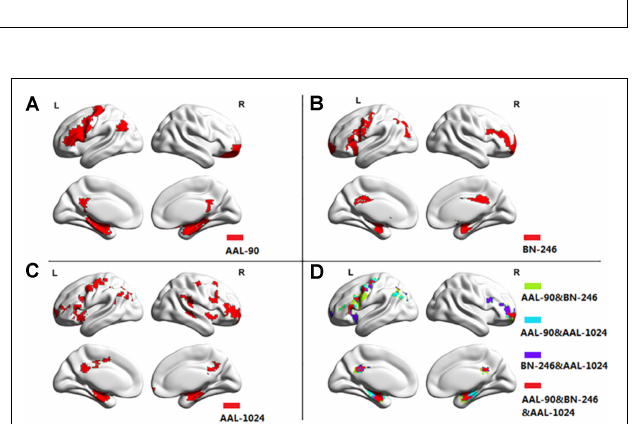
FIGURE 2 | The flowchart of the proposed method for MCI discrimination.